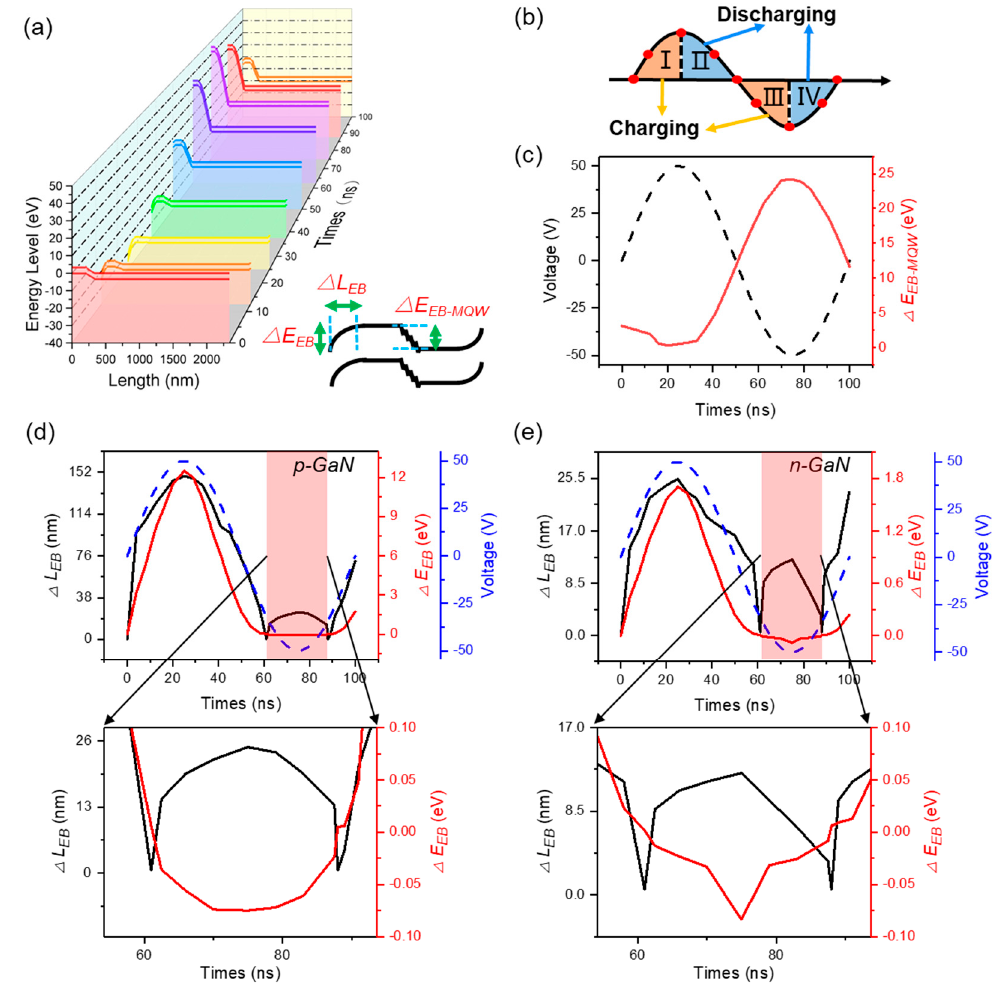
Figure 4. Energy band change of nano-LED operating in NEC&NCI mode. ( a ) Energy band in a voltage cycle. Bottom right corner: definition of ∆ L EB and ∆ E EB . ( b ) Schematic charging and discharg- ing process. ( c ) Energy band in the MQWs region. ( d ) Energy band in the p-GaN terminal. ( e ) Energy band in the n-GaN terminal.